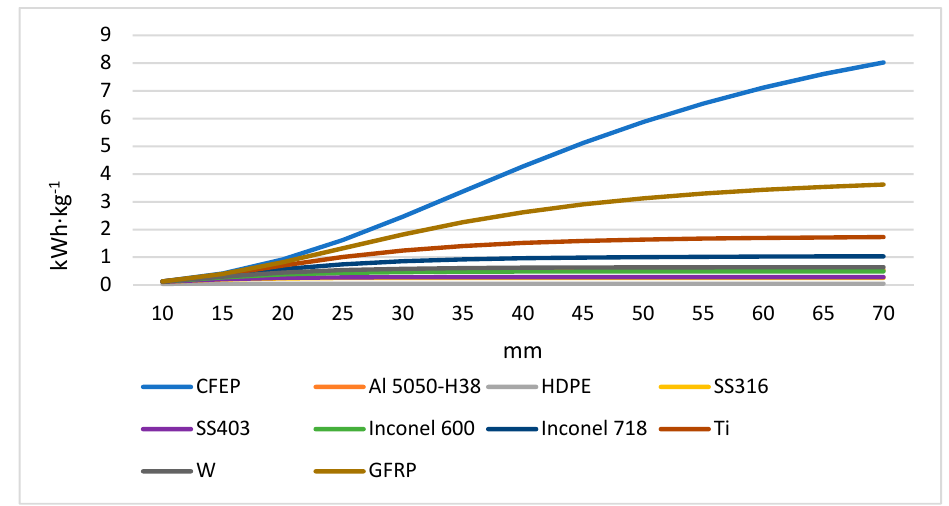
Figure 5. GED of spheres made of several materials with ID from 10 up to 70 mm, at 700 daN cm − 2 of inside pressure.